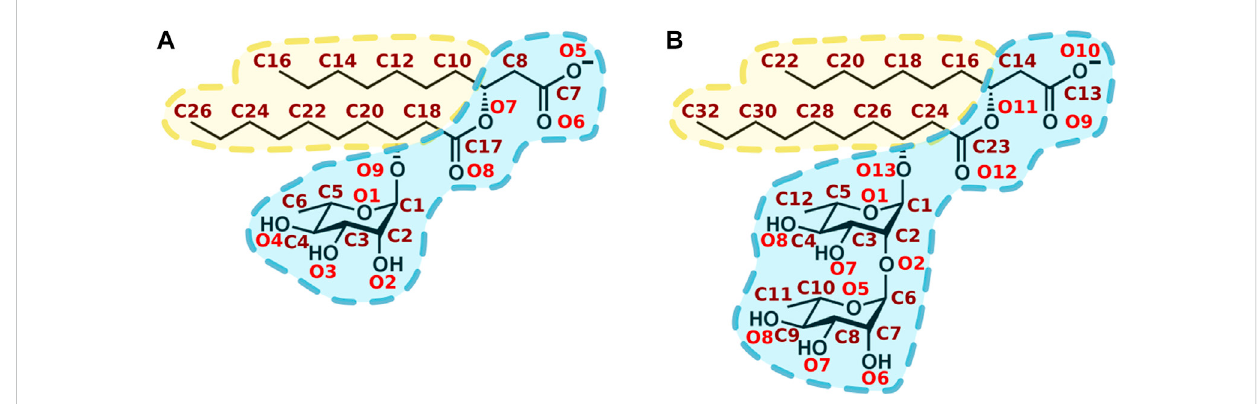
FIGURE 1 Chemical structure of main rhamnolipids produced by Pseudomonas aeruginosa . (A) α -L-rhamnopyranosyl- β -hydroxydecanoyl- β - hydroxydecanoate (mono-RL). (B) 2-O- α -L-rhamnopyranosyl- α -L-rhamnopyranosy- β -hydroxydecanoyl- β -hydroxydecanoate (di-RL). Oxygen and carbon atoms are respectively labelled in red and maroon. Hydrophilic and hydrophobic moieties are respectively shown in blue and in